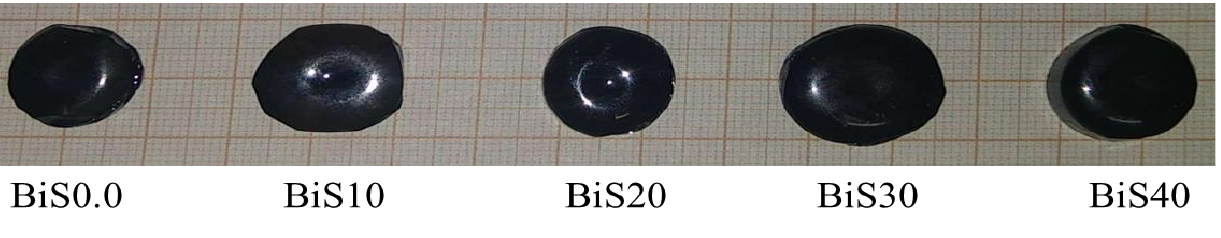
Figure 1. Glass system image.